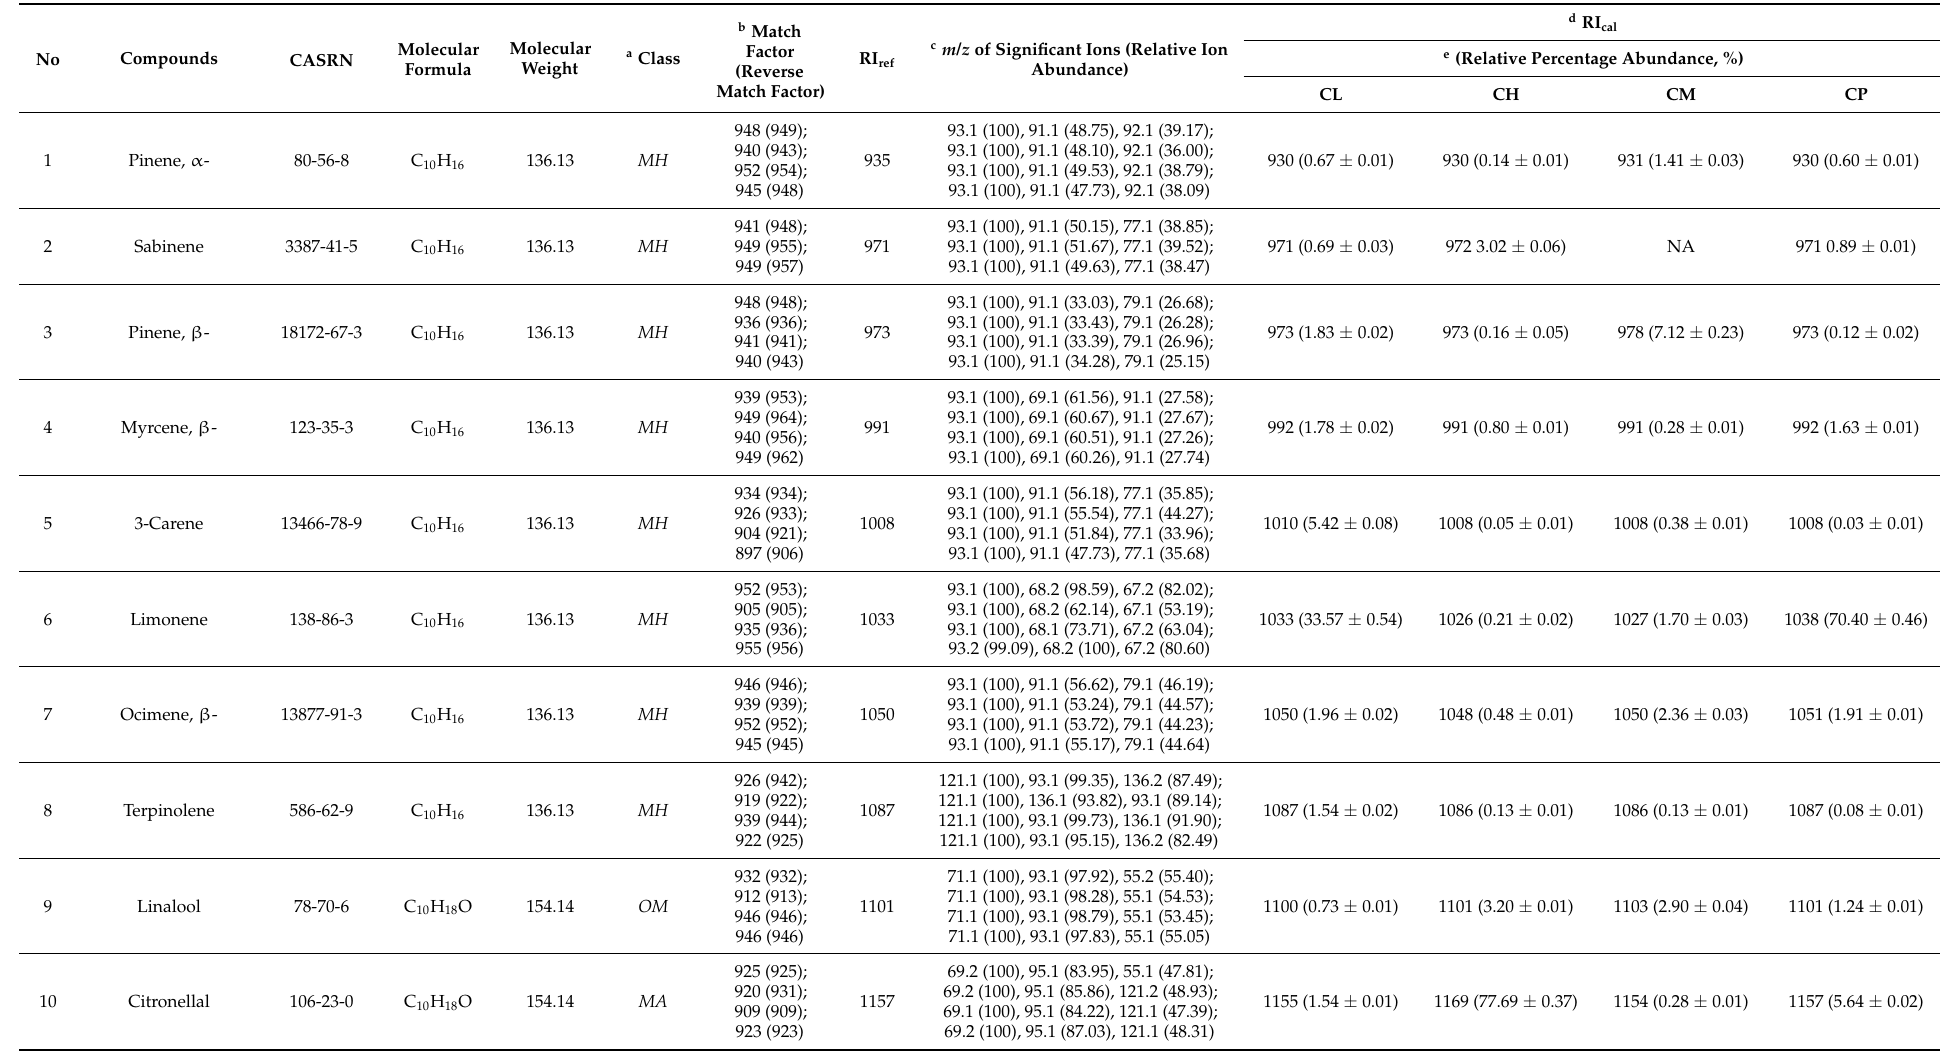
Table 1. Major secondary compounds tentatively identified in Citrus spp. leaf EOs using